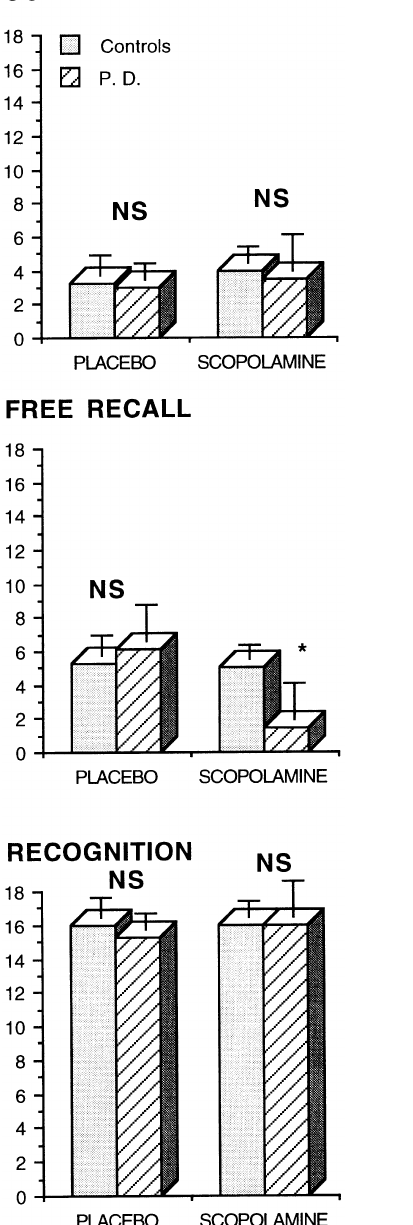
Fig. 3. Word repetition priming task.